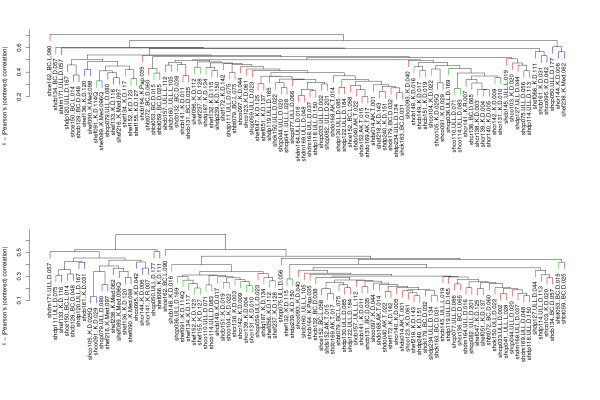
Hierarchical clusterings of training dataset. Hierarchical clustering of all the training dataset samples (upper) on all 23,9946 genes and (lower) on the 1,908 genes that define the three ERBB2/ESR1 subtype centroids. In both dendrograms, the training dataset samples are colored according to which ESR1/ERBB2 subtype they belong. ESR1+/ERBB2- samples are in red; ERBB2+ samples are in green; and ESR1-/ERBB2- samples are in blue.